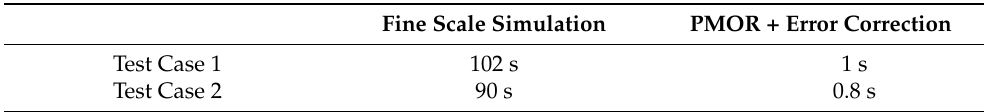
Table 13. Time (seconds) comparison for the two test cases between fine-scale simulation and reduced- order model with error